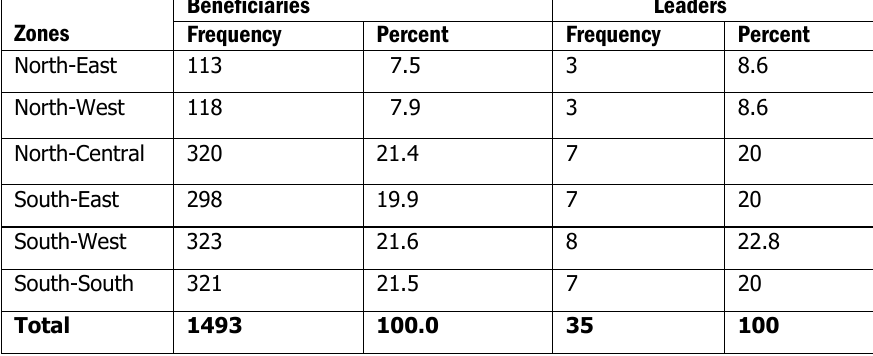
Table 2: Geopolitical Zones of the Respondents